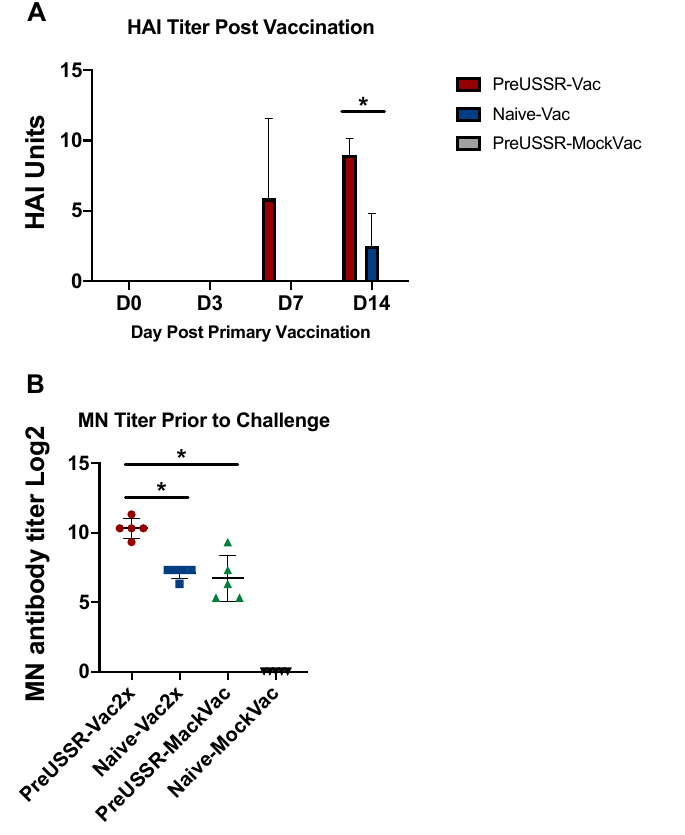
Figure 8. Antibodies elicited post vaccination in the PreUSSR-Vac2x ferrets were detected earlier and had increased neutralization activity compared to other experimental groups. Serum was collected at early time points after primary vaccination (Days 0, 3, 7, and 14 post vaccination). ( A ) HAI assays were performed as previously described using sera isolated from blood collection post vaccination against the Cal / 07 (pH1N1) virus to determine the dynamics of antibody generation after vaccination. ( B ) Microneutralization assays were performed by standard protocol on MDCK cells using serum from all experimental groups post vaccination and prior to challenge. For simplicity, only the PreUSSR-Vac2x, PreUSSR-MockVac, Naïve-Vac2x and Navie-Mock Vac groups are shown. Student’s t -test was conducted to compare results between each group, * p < 0.05.